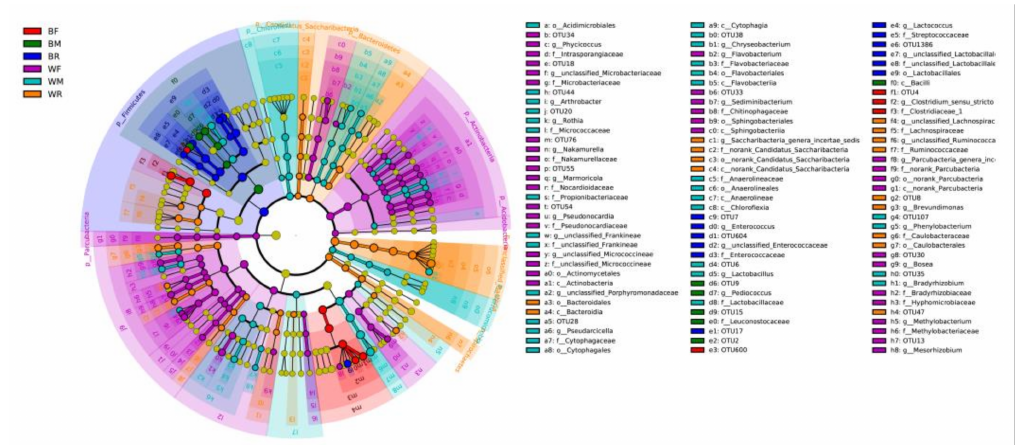
Figure 3. LEfSe (LDA Effect Size) analysis of the gut microbiota in cultivated and wild Mastacembelus armatus